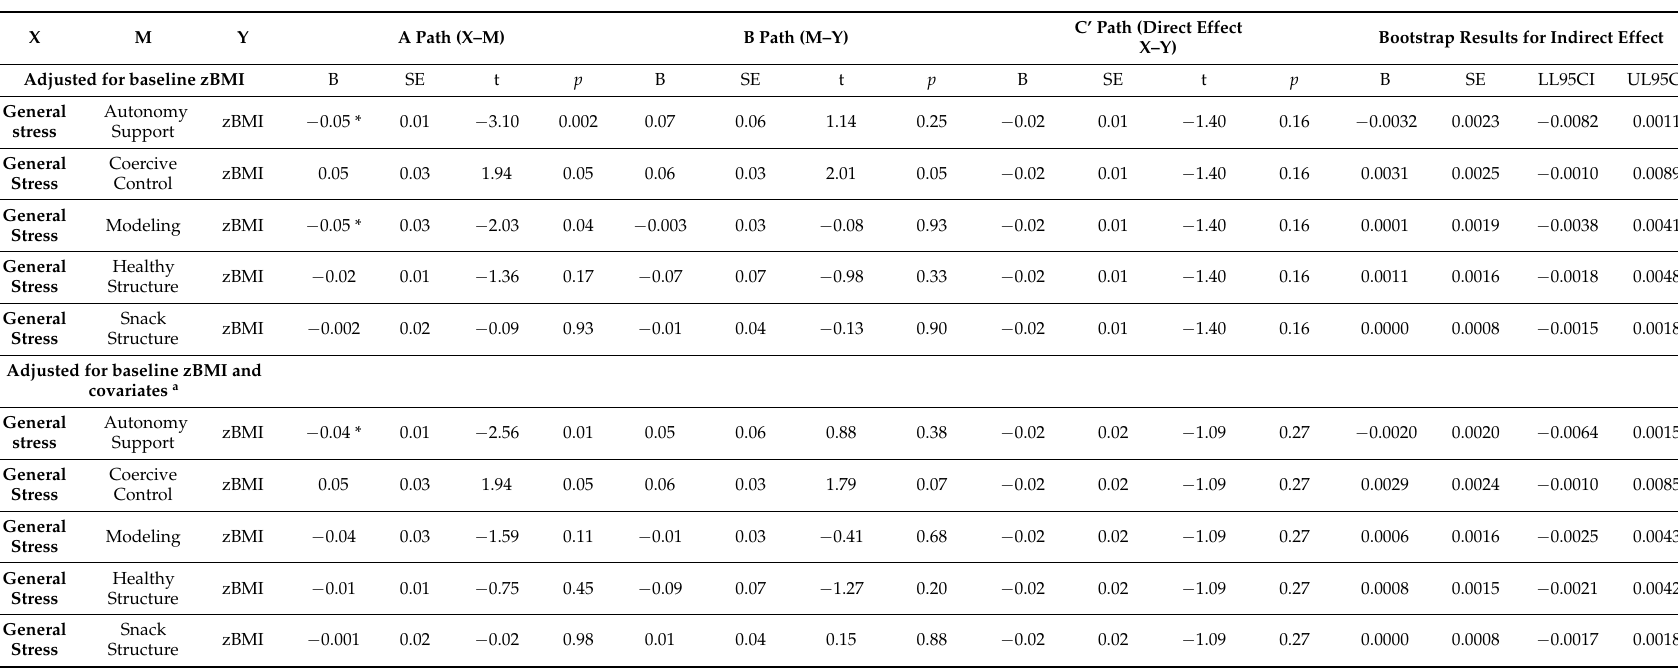
Table 4. Mediation analysis of the link between parental general stress at baseline (X) and adolescent z BMI at follow-up (Y) by Food Parenting Practices at follow-up